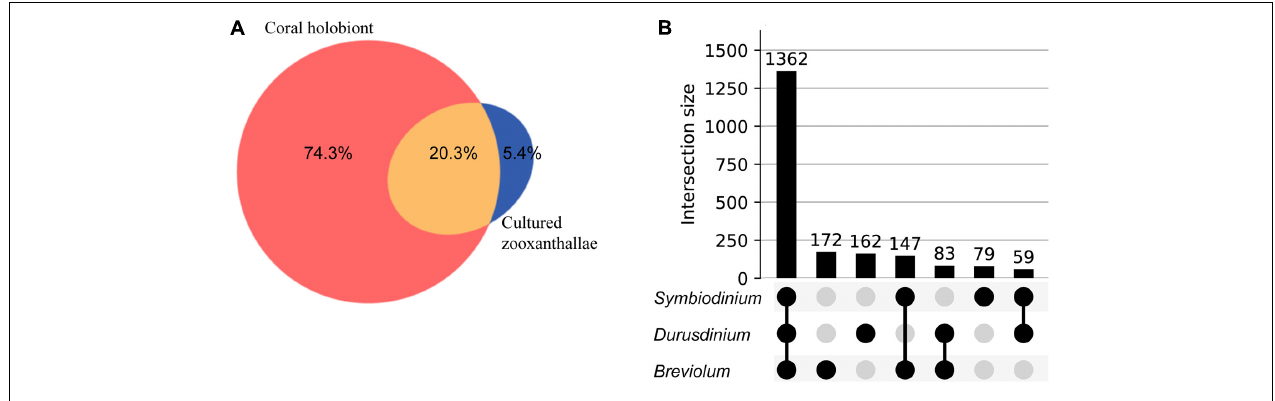
FIGURE 6 | Venn diagram and UpSet plot representation of metabolomics data acquired on cultured Symbiodiniaceae. (A) Shows the overlap in detected metabolite features between corals and the cultured Symbiodiniaceae: unique to M. cavernosa corals (peach), unique to Symbiodiniaceae (blue) and shared (orange). (B) Shows UpSet plot of distribution of metabolite features across three species of cultured Symbiodiniaceae arranged by decreasing frequency.